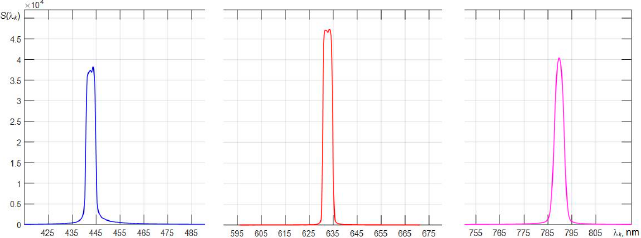
Figure 5. Spectra of three lasers interpolated on a fine scale of counts (4096 counts were used in the range from 330.4 to 1100 nm) registered with an AvaSpec 2048L spectrometer. The documentation for the AvaSpec 2048L indicates that its spectral resolution when using a diffraction grating with a period of 300 lines/mm and an entrance slit width of 100 μ m is 4.8 nm. The values of the resolving power of the AvaSpec spectrometer calculated by us at the half-height of the spectral peaks of laser radiation turned out to be equal: r = 4.3 nm at λ = 443.7 nm, r = 4.4 nm at λ = 632.8 nm, and r = 4.4 nm at λ = 789.7 nm, which is close enough to the r resolution declared by their manufacturer. The shape of the regis-